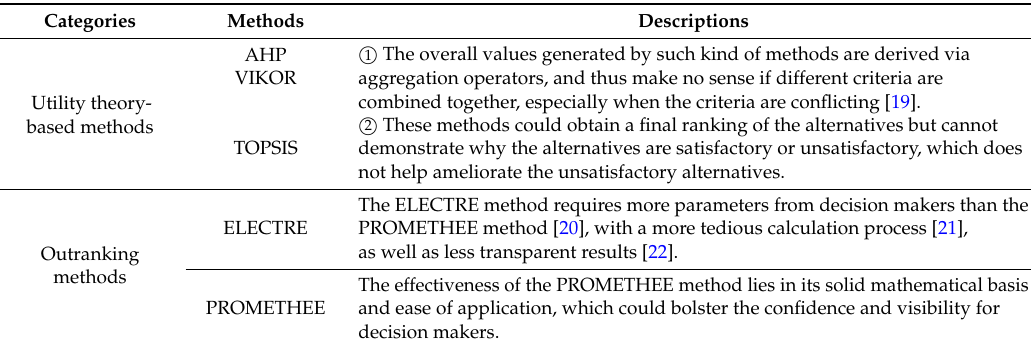
Table 1. Descriptions of MCDM